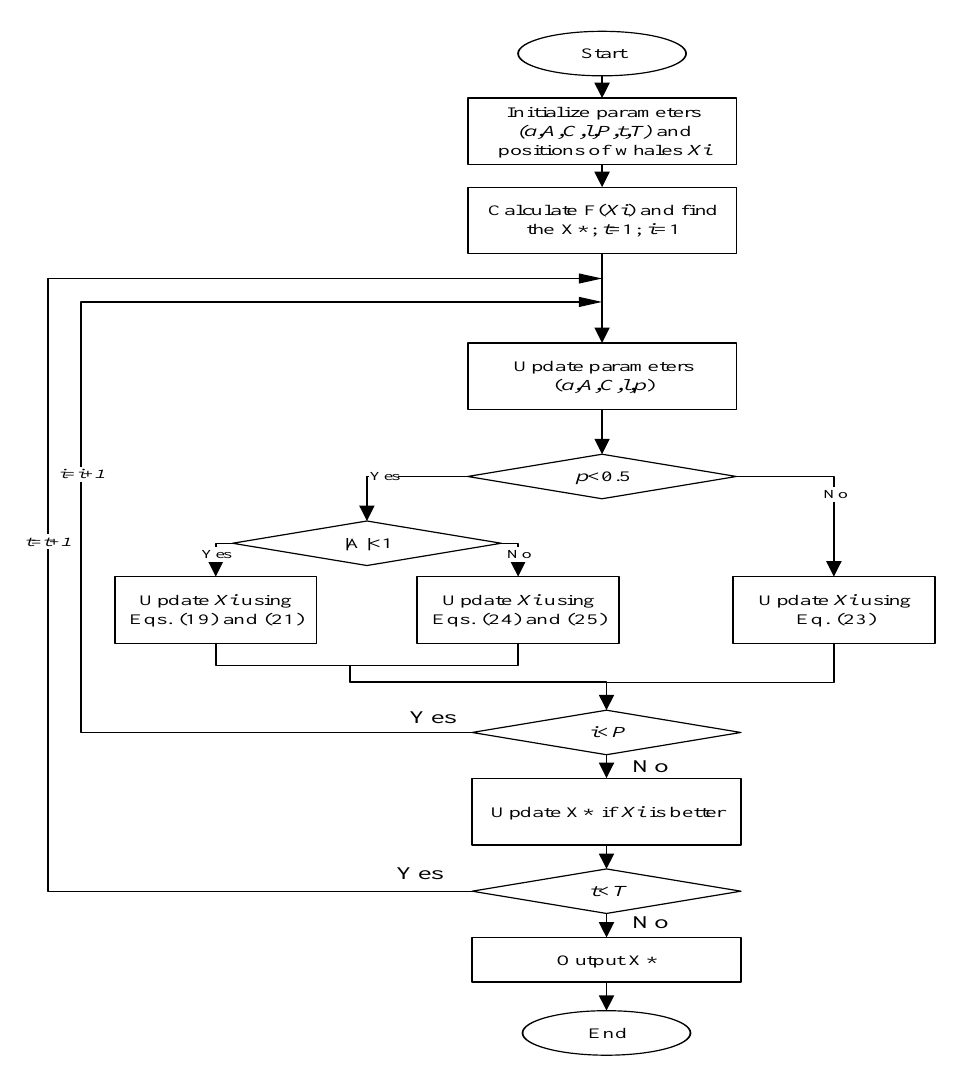
Figure 9. The workflow of Algorithm A1 of the